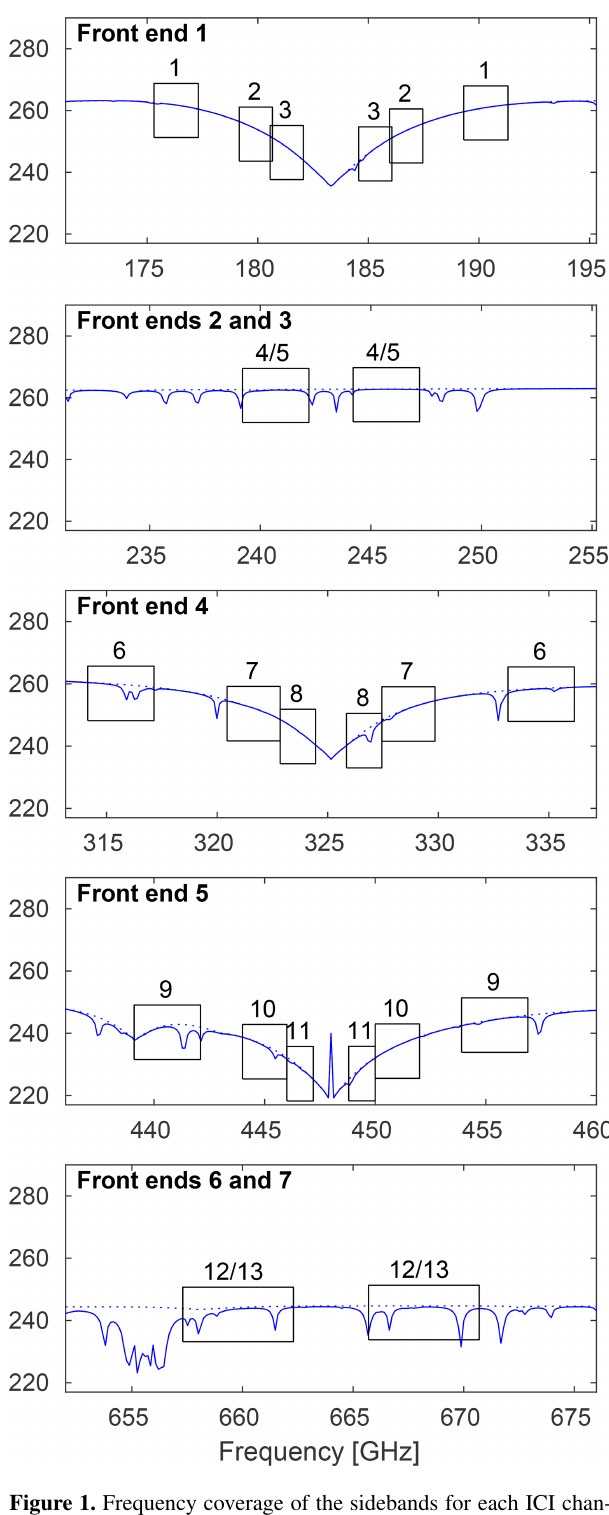
Figure 1. Frequency coverage of the sidebands for each ICI chan- nel. The simulated spectrum (blue line) is based on a mid-latitude winter scenario. The dotted lines are simulations ignoring ozone.